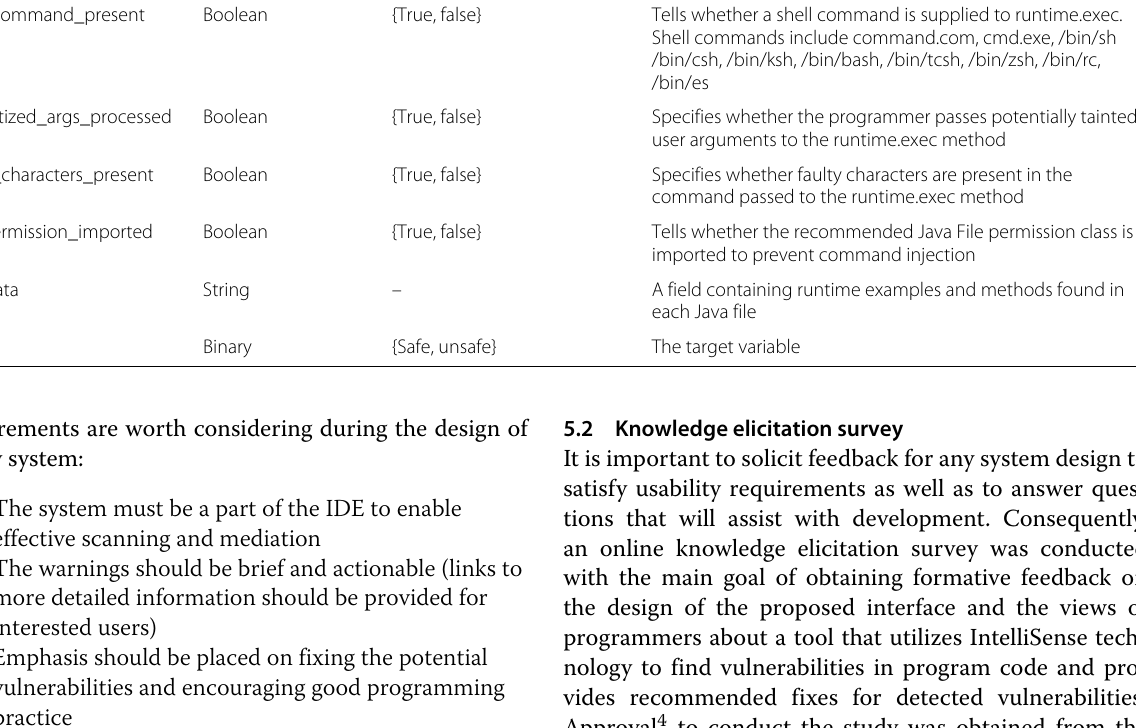
Table 2 Features for detecting OS command injection Feature Data type Possible values Description